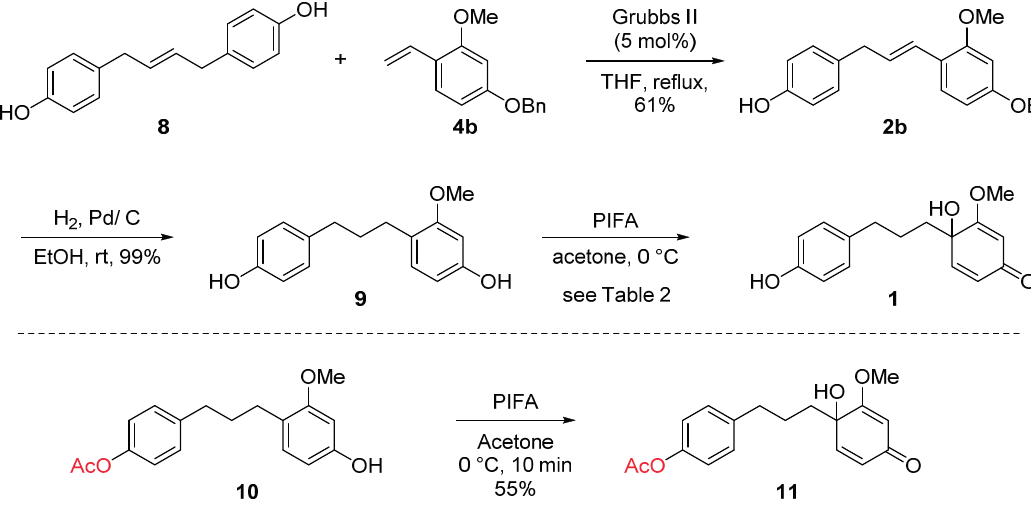
Scheme 4. Completion of total synthesis of 1